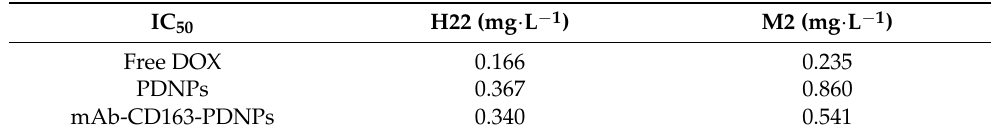
Table 3. IC 50 values of free DOX, PDNPs, and mAb-CD163-PDNPs against H22 cells and M2-type macrophages, respectively.